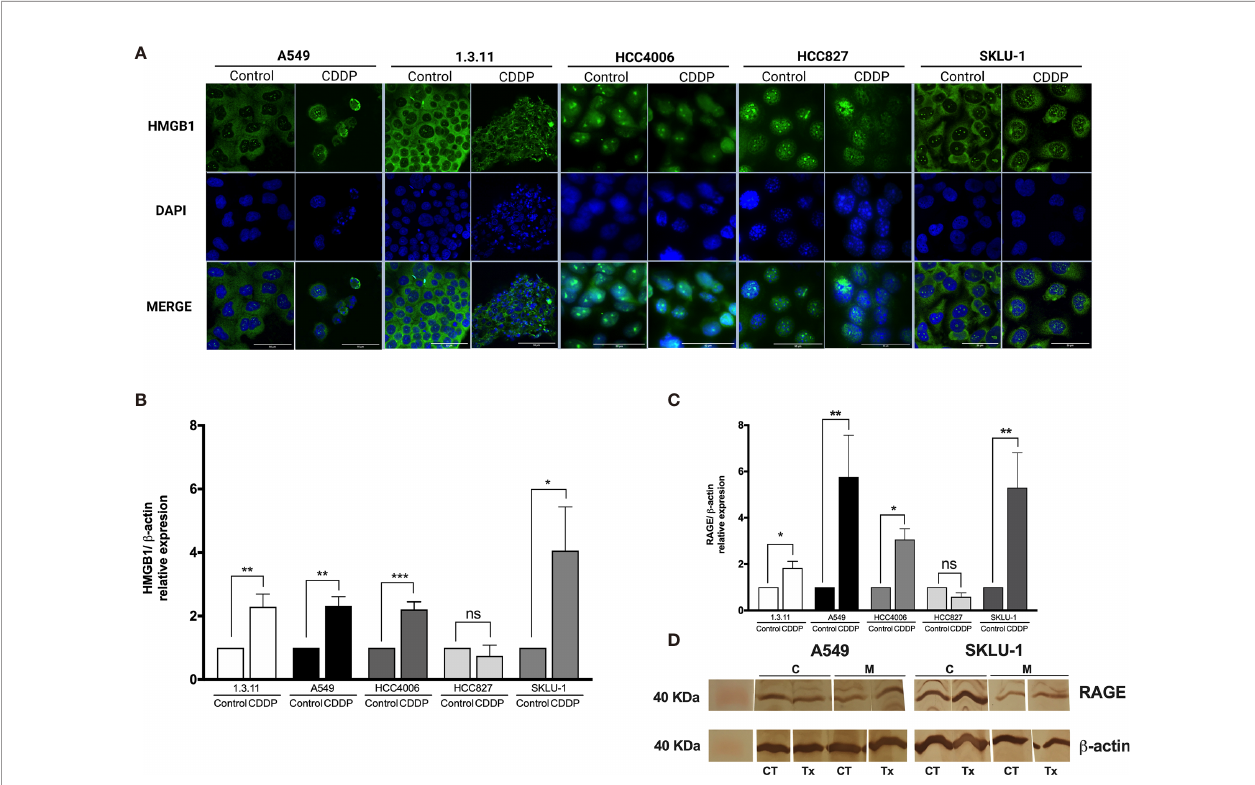
FIGURE 3 | HMGB1 and receptor for advanced glycation end products (RAGE) in lung adenocarcinoma cell lines and in cisplatin (CDDP)-persistent cells. (A) HMGB1 is localized to the cytoplasm of untreated tumor cells, and nuclear relocalization occurs after a single exposure to CDDP. For nuclear staining, DAPI was used. Merge is indicated. Indirect immuno fl uorescence staining was employed. Magni fi cation: ×400. (B) HMGB1 and (C) RAGE expression was measured by qPCR in untreated tumor cell lines and in CDDP-persistent cells. Three experiments in duplicate were done. The relative expression of each cell line between treated and untreated cells is indicated. (D) Protein expression level of RAGE (43 kDa) in CDDP-persistent and untreated cells from A549 and SKLU-1 cell lines. Protein bands detected at around 40 kDa from cytoplasmic (C) or membrane (M) extracts are shown from control (CT) or CDDP (Tx)-treated cells. b -Actin (42 kDa) was employed as a constitutive expression control. Data is shown as mean ± SD. The signi fi cant difference between treatment and control is indicated with asterisks (* p < 0.05, ** p < 0.005, *** p < 0.0005, ns, non-signi fi cant).